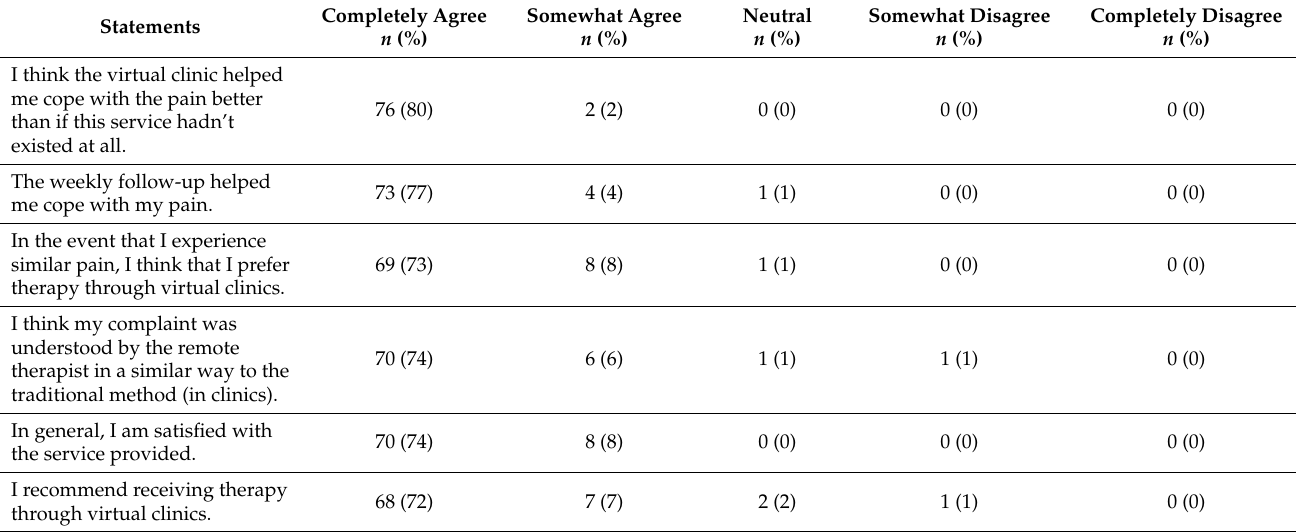
Table 3. Satisfaction levels related to the telerehabilitation